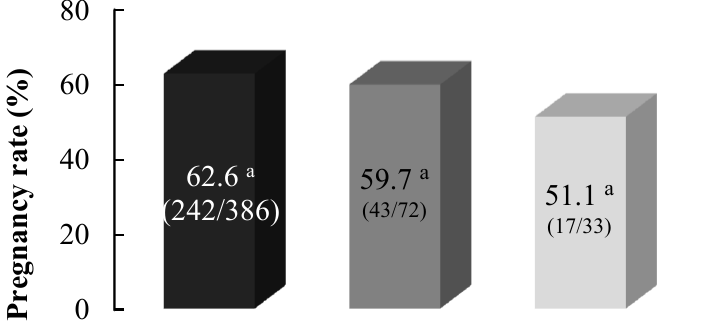
Figure 4. Pregnancy rates (%) after embryo transfer in camels with a negative and positive uterine culture. Different superscripts indicate significant difference in the frequency distribution of subjects among groups ( p < 0.05).